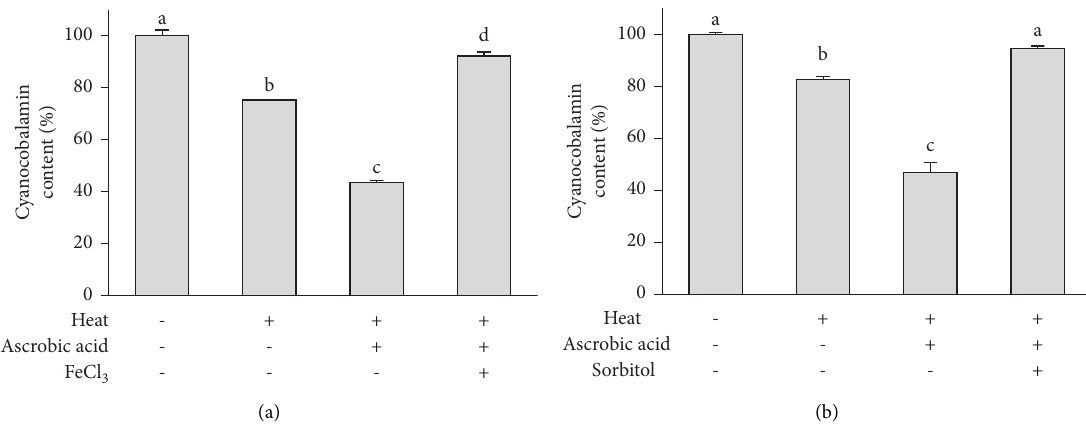
Figure 4: Effects of micronutrient and sugar alcohol on the degradation of cyanocobalamin against the combination effect between heat (124 ° C, 10min) and ascorbic acid (100 mg/kg) treatment: (a) ferric chloride (1mM) or (b) sorbitol (0.25%, w/v) was treated in 100mg/kg cyanocobalamin standard solution and heated at 124 ° C for 10min. After heating, cyanocobalamin in the samples was measured by HPLC analysis. Values with different letters (a–d) are significantly different at p < 0 . 01 by post hoc Tukey’s test.